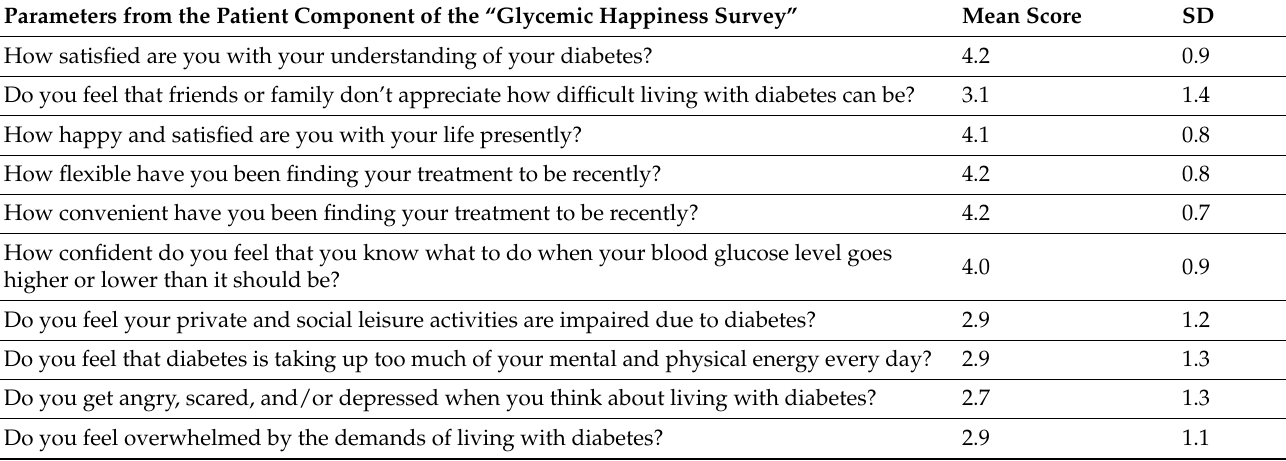
Table 3. Mean Likert scale scores from the patient component of the glycemic happiness survey ( N = 167). Parameters from the Patient Component of the “Glycemic Happiness